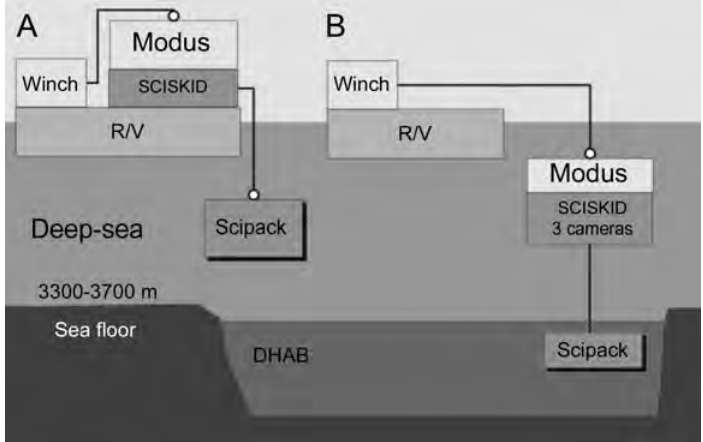
Fig. 4. Operational concept of BIODEEP mission for sampling and surveying: A – deployment of SCIPACK from the ship; B – operation of the MODUS-SCIPACK system at the interface of the